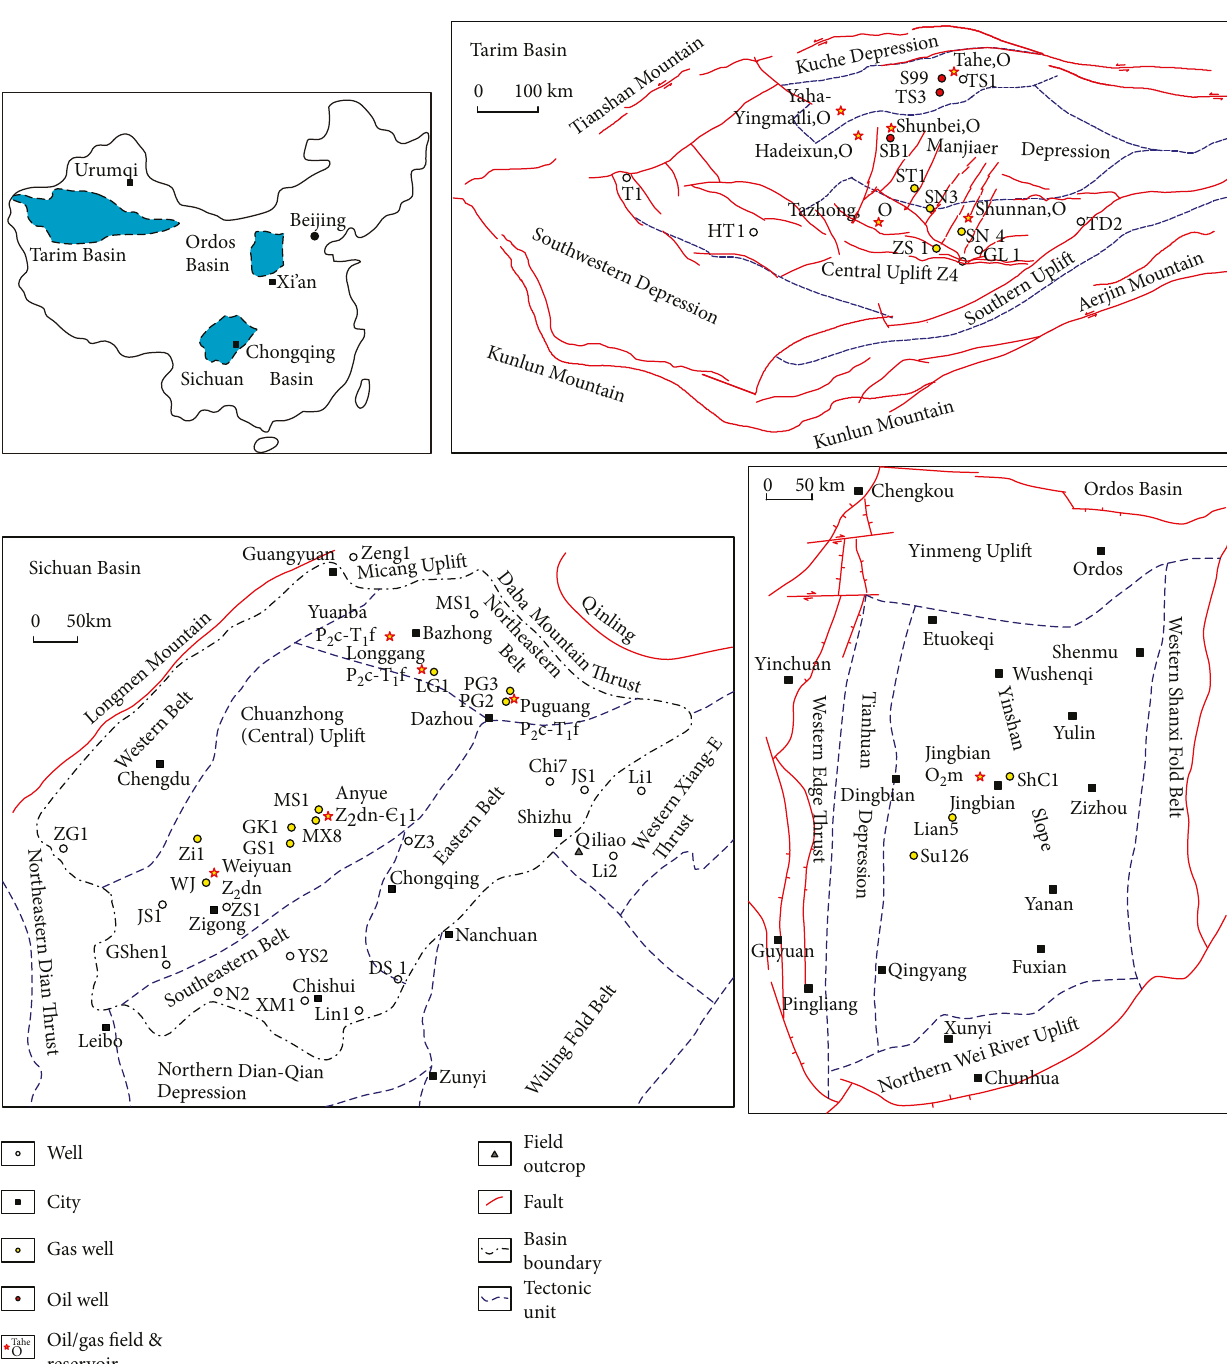
Figure 1: Distribution of major carbonate reservoirs and drilling wells in the Tarim, Sichuan, and Ordos basins in